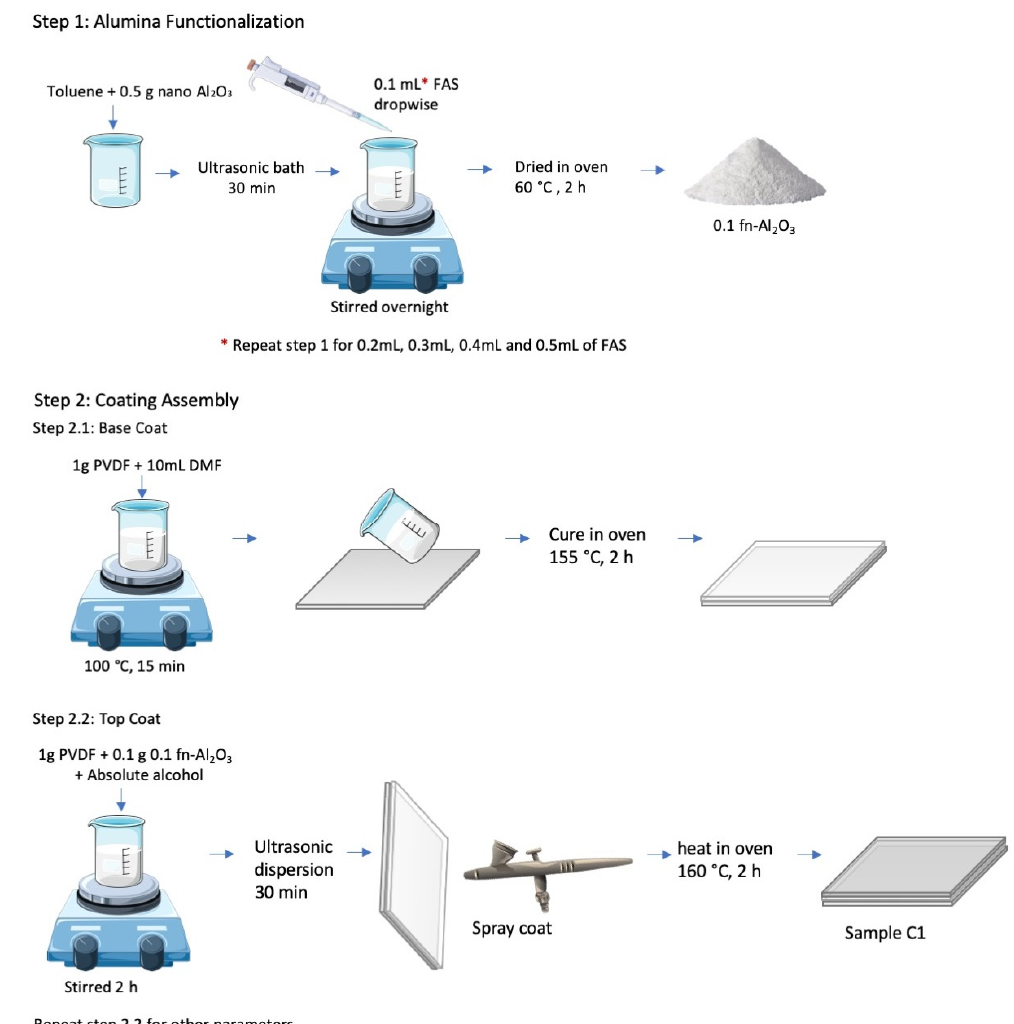
Figure 1. Illustration of the experimental procedure in this study starting from the functionalization process to the assembly of the bi-layer coating.